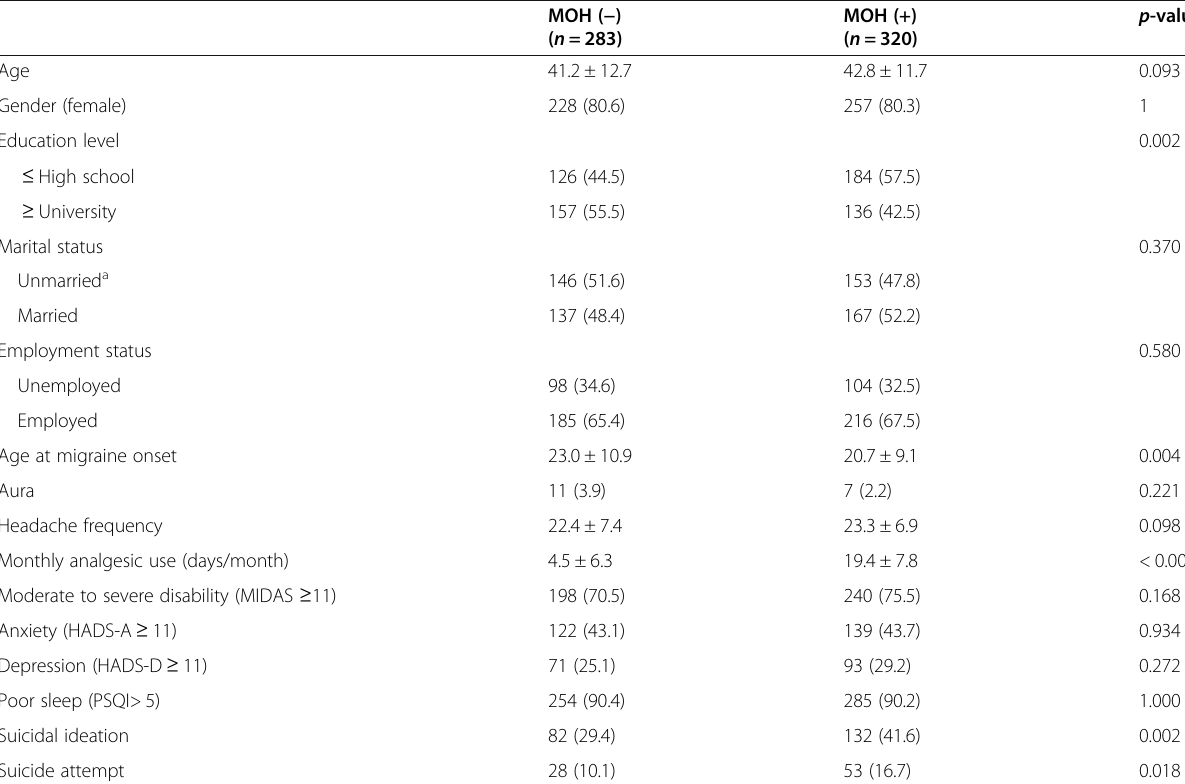
Table 1 Comparisons between chronic migraine patients with and without coexisting medication overuse headache